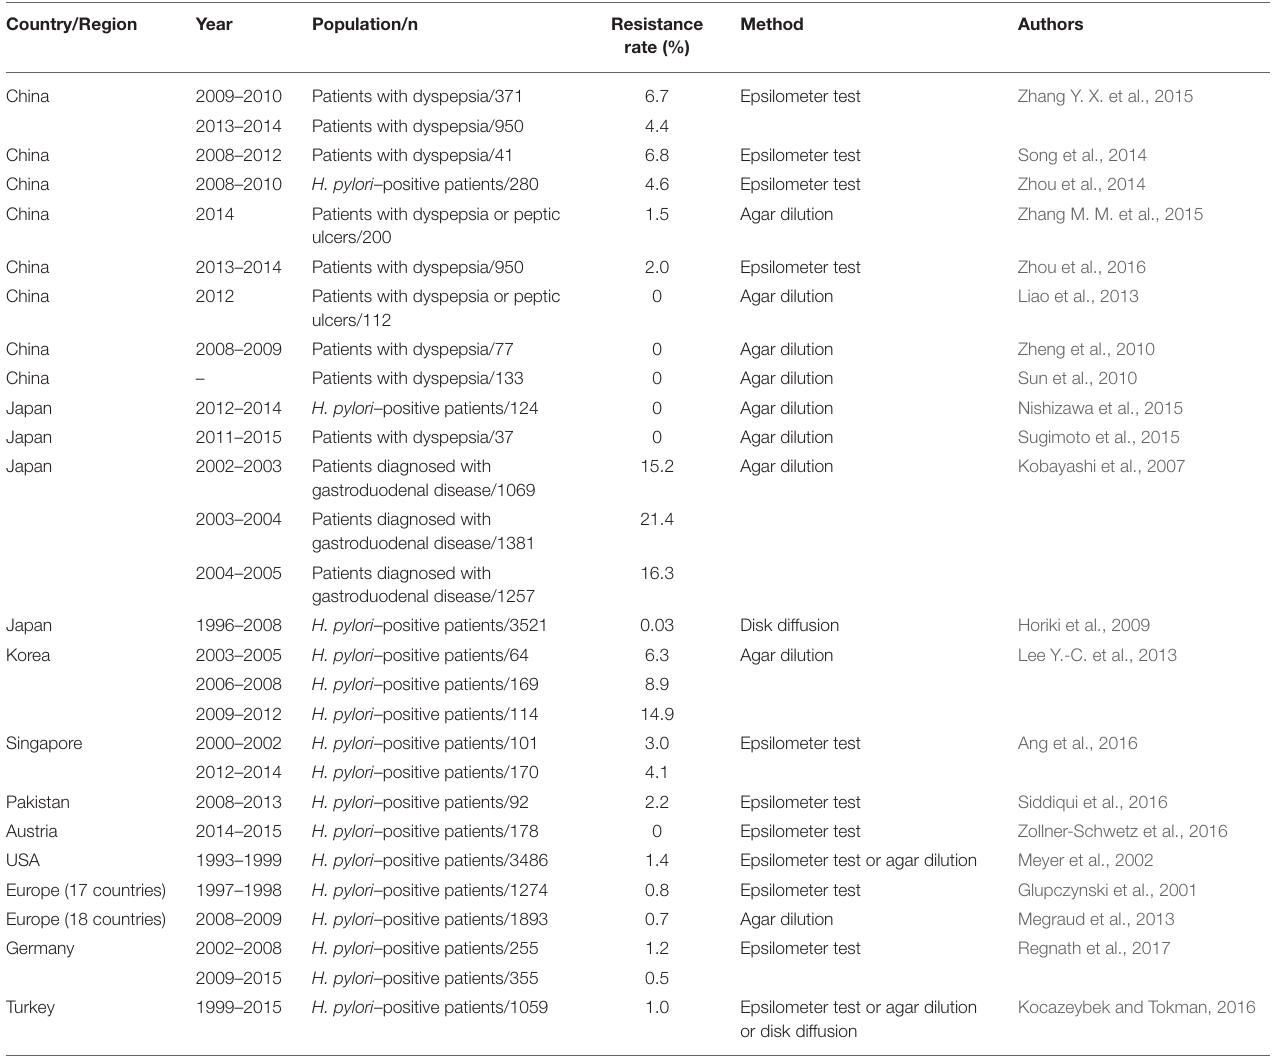
TABLE 5 | Primary H. pylori amoxicillin resistance.